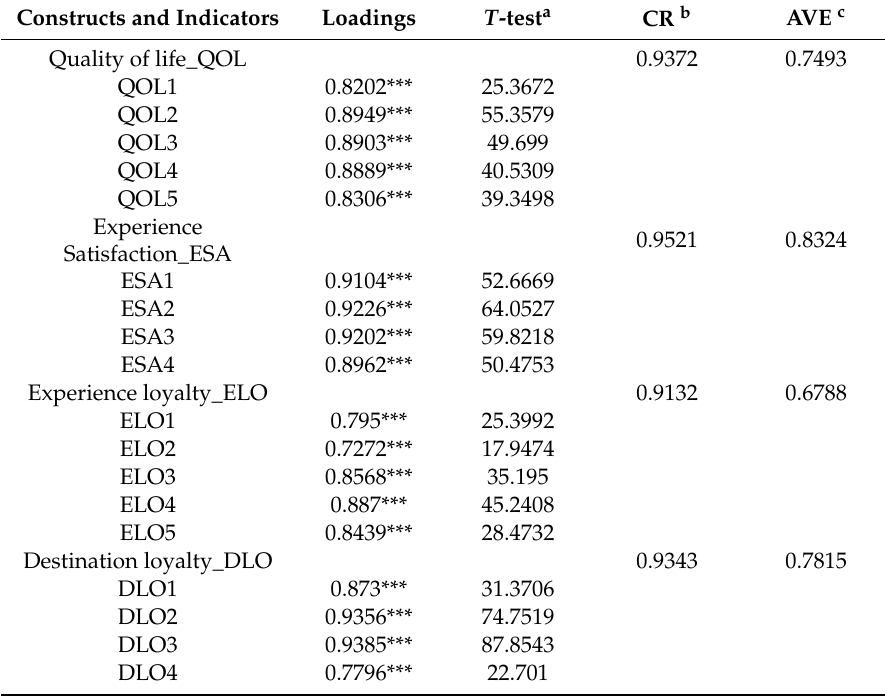
Table 6. Measurement model assessment: reflective indicators (II).